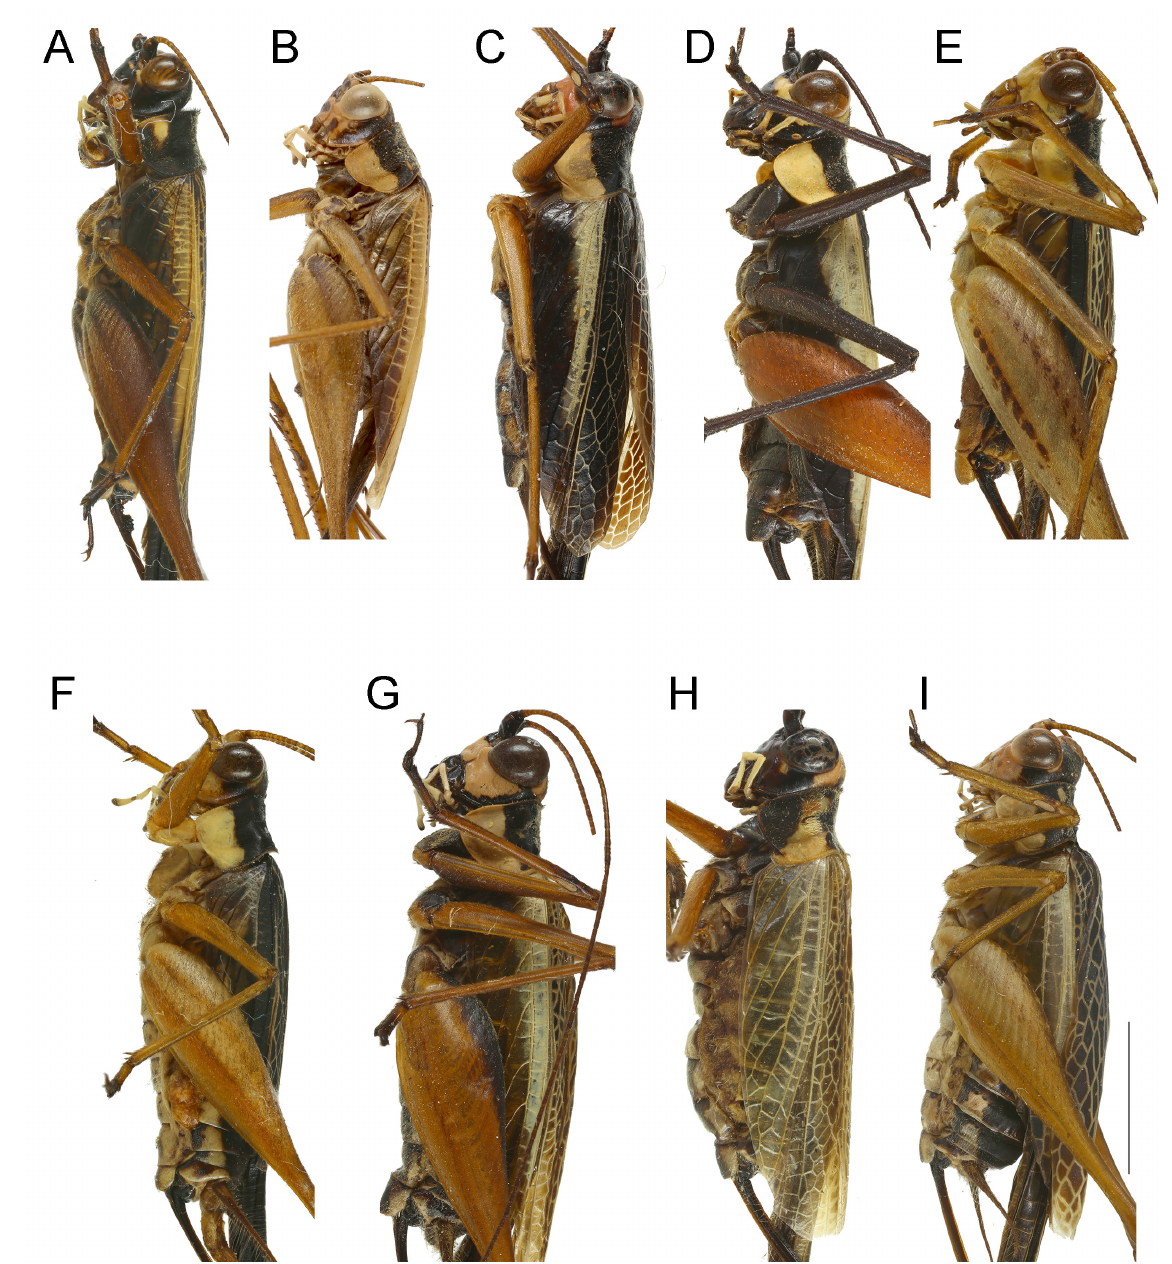
Fig. 12. Body in lateral view. A . Nisitrus brunnerianus Saussure, 1878. B . N. crucius Robillard &